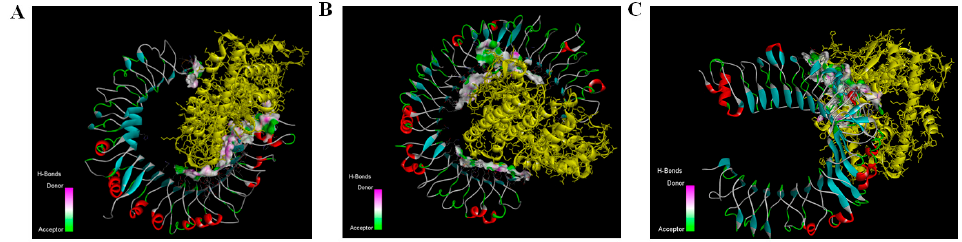
Figure 5. Molecular docking and 3D structures of vaccine–receptor complexes ( A ) Vaccine—TLR2 docked complex ( B ) Vaccine—TLR3 docked complex ( C ) Vaccine—TLR-4 docked complex.